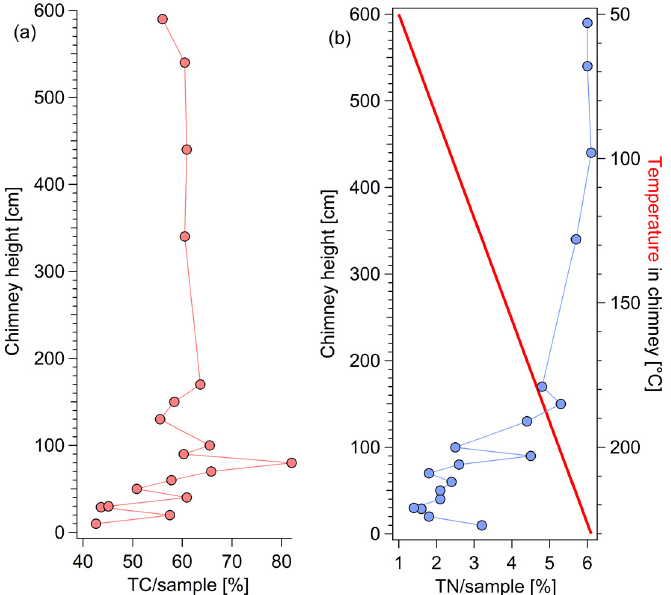
Figure 3. Vertical profiles of the mass concentrations (%) of ( a ) total carbon (TC) and ( b ) total nitrogen (TN) in the chimney deposit samples with estimated temperature (red line) in the chimney inner wall. On the top of the chimney, there is a chimney cap cover (ca. 40 cm high), thus the temperature of the chimney top can be estimated to be around 50 °C or more in winter when the outside temperature is 0 °C or less in winter overnight.